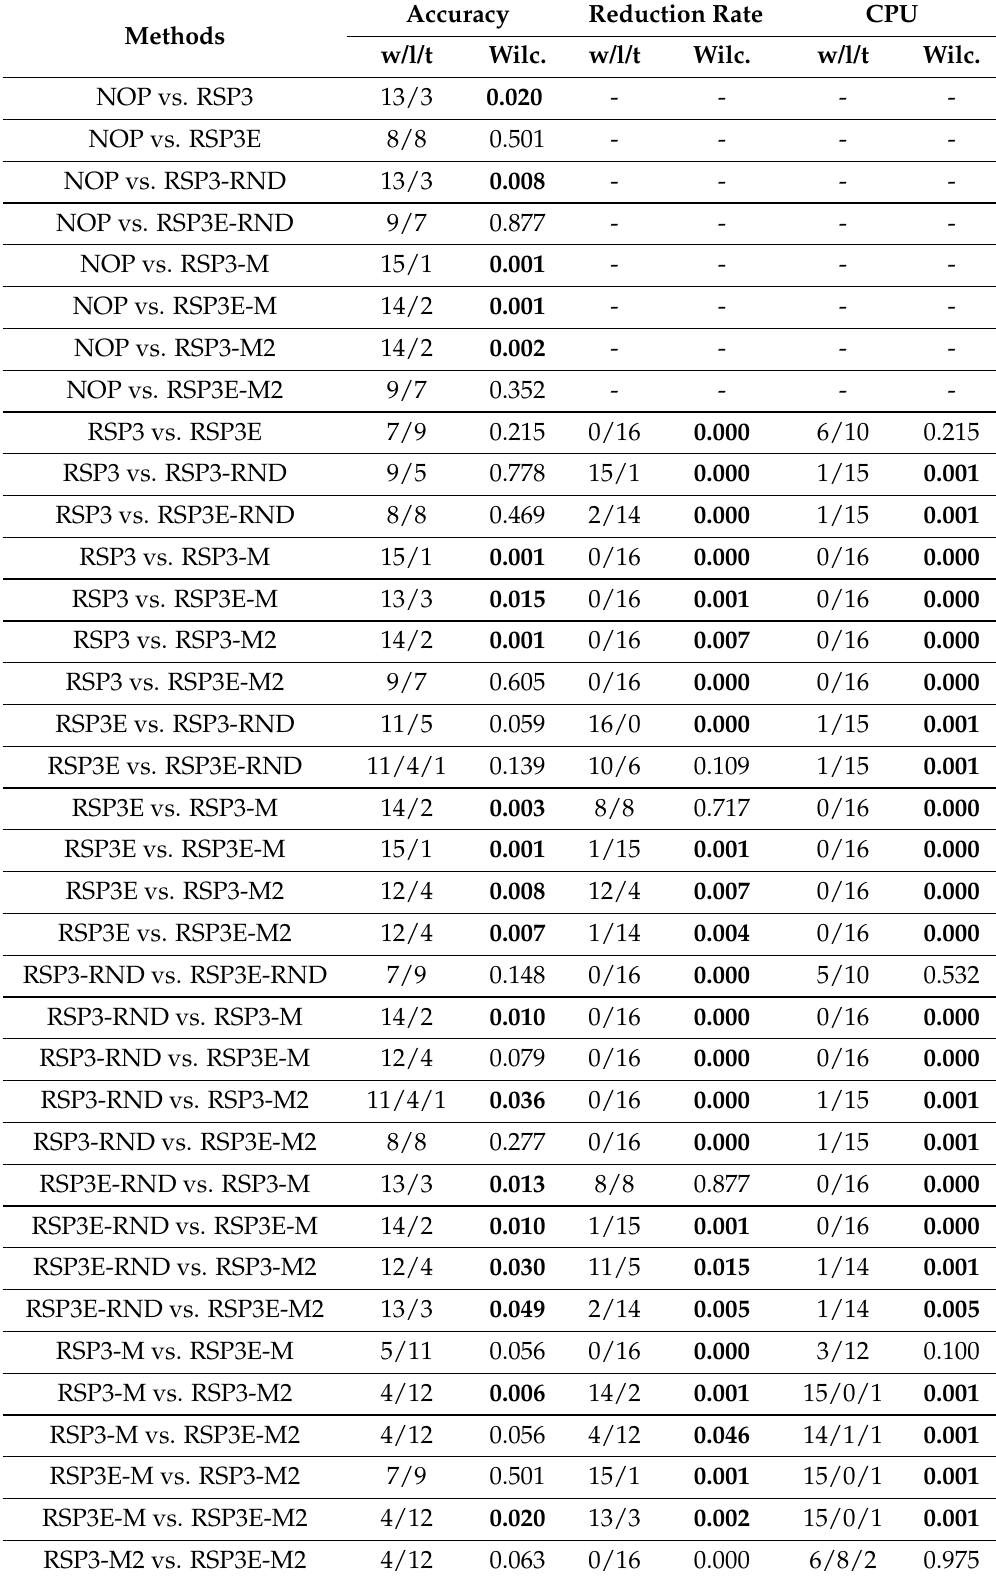
Table 4. Results of Wilcoxon signed rank test on ACC, RR and CPU